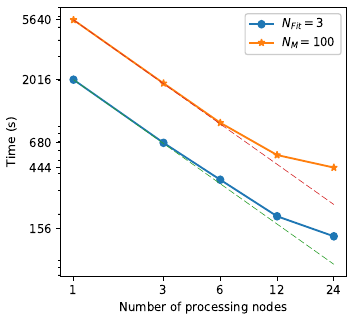
Figure 6. Parallelization performance of the proposed PB-AnDA setting: we report in logarithmic scale the computational time of the assimilation of 24 patches using the standard PB-AnDA with N M = 100 members (orange,-) and using the clustering-based version with N Fit = 3 clusters (blue,-). The dashed lines indicate the computational time of a theoretically-optimal multi-core